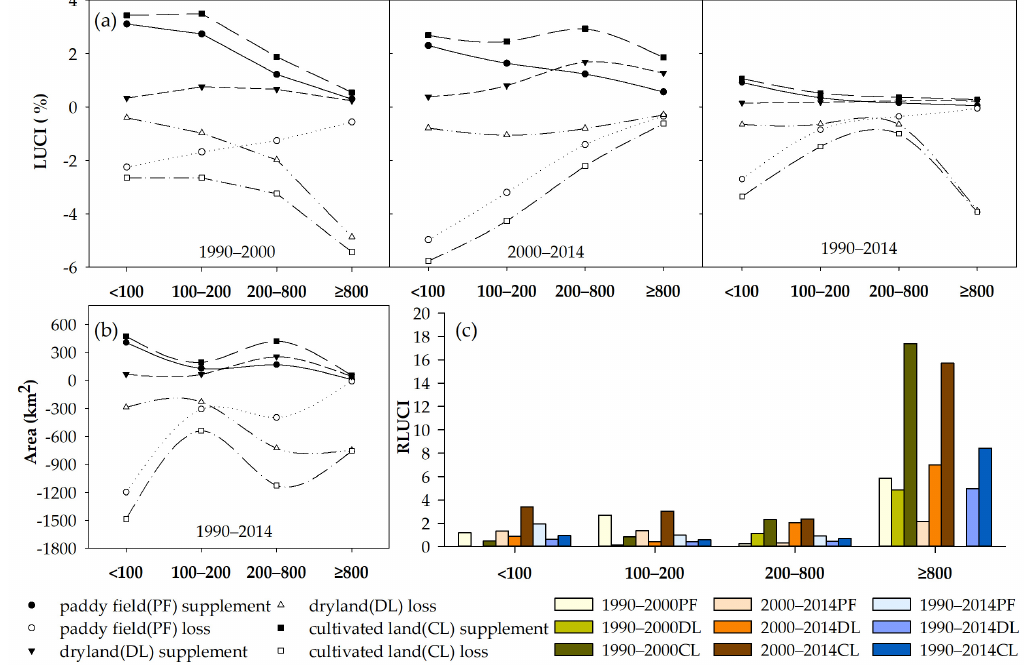
Figure 4. Changes in cultivated land at di ff erent altitudes. ( a ) The variation in land-use change intensity at di ff erent altitudes acrossing di ff erent periods, ( b ) the change of area in cultivated land at di ff erent altitudes during 1990–2014, ( c ) the ratio of cultivated land change at di ff erent altitudes compared to that in the whole Hunan province.